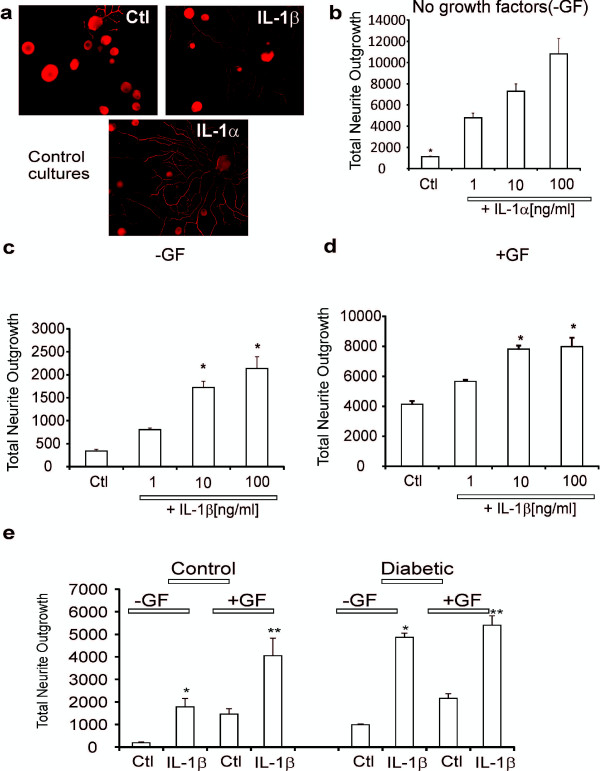
IL-1α and IL-1β significantly increased neurite outgrowth in normal and diabetic neurons. In (a) images of cultures stained for neuron-specific β-tubulin III are shown for untreated control (Ctl), treated for 24 h with IL-1β (10 ng/ml) or treated with IL-1α (10 ng/ml). Size marker indicates 100 μm. In (b) is shown total neurite outgrowth of neurons in response to a range of IL-1α concentrations grown for 24 h under defined conditions without neurotrophic growth factors (GF). Values are means ± SEM (n = 3 replicates); *p < 0.05 vs control (oneway ANOVA with Dunnett’s test). In (c) is shown total neurite outgrowth of neurons in response to a range of IL-1β concentrations without neurotrophic growth factors. Values are means ± SEM (n = 3 replicates); *p < 0.05 vs control (oneway ANOVA with Dunnett’s test). In (d) is shown total neurite outgrowth of neurons in response to a range of IL-1β concentrations in the presence of low dose cocktail of neurotrophic growth factors. Values are means ± SEM (n = 3 replicates); *p < 0.05 vs control (oneway ANOVA with Dunnett’s test). In (e) is shown total neurite outgrowth for sensory neurons isolated from control or 3–5 month STZ-diabetic rats cultured for 1 day ± IL-1β (at 10 ng/ml). Cultures were performed with or without neurotrophic factors. Values are the means ± SEM (n = 3 replicates). For control or diabetic *p < 0.05 vs control (Ctl) and **p < 0.05 vs Ctl (two-way ANOVA with Bonferroni’s test).